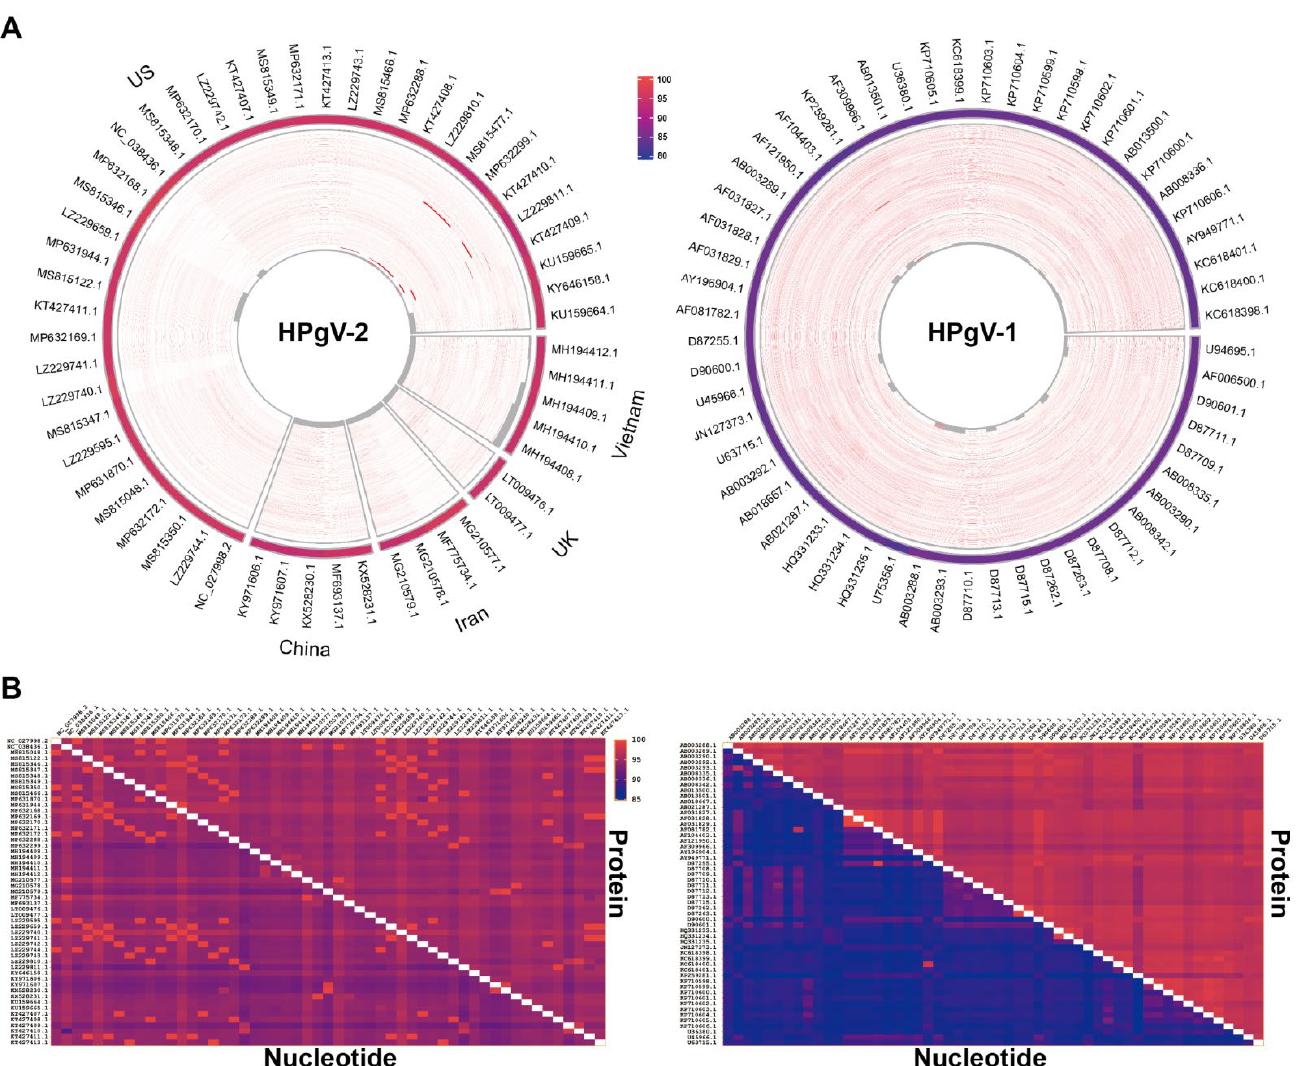
Figure 2. Nucleotide sequence diversity and pairwise alignment of HPgV-1 and HPgV-2 isolates with different countries of origin. ( A ) Whole-genome sequences of HPgV-2 and HPgV-2 from Vietnam, United Kingdom, Chinese and United States isolates were aligned with MAFFT multiple alignment and visualized with circles. The consensus sequence was generated with a 70% threshold. Mismatches are highlighted in red, and gaps are indicated in gray. The overall identities of each strain are indicated on a scale from 80% (blue) to 100% (red) in the peripheral ring. ( B ) Pairwise alignment of the nucleotide sequences and protein sequences of HPgV-1 (right panel) and HPgV-2 (left panel) strains. The heat map scale is from 85% (blue) to 100% (red).